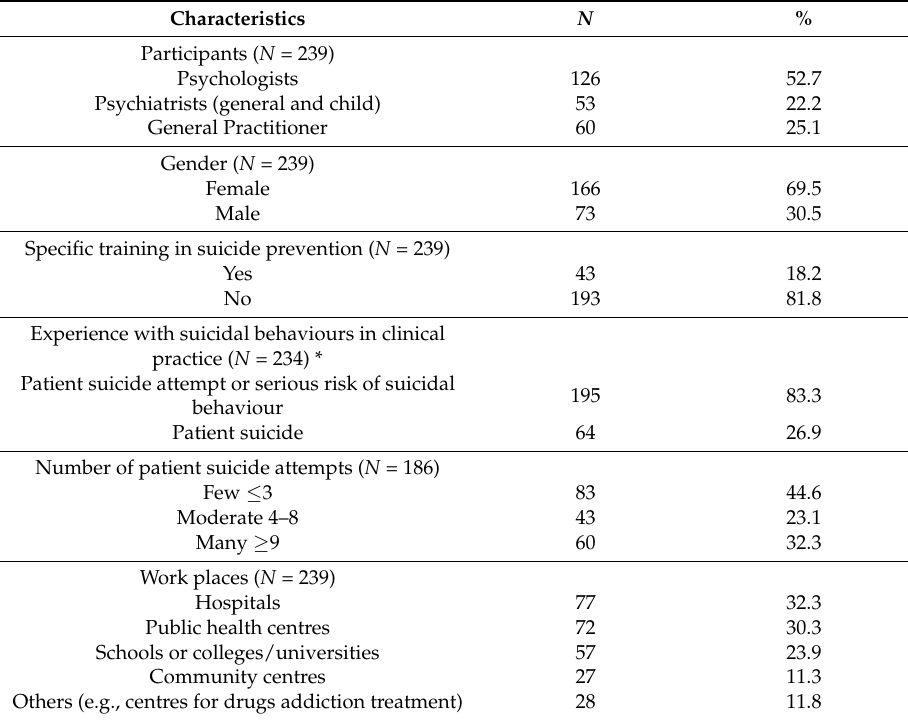
Table 1. Participants’